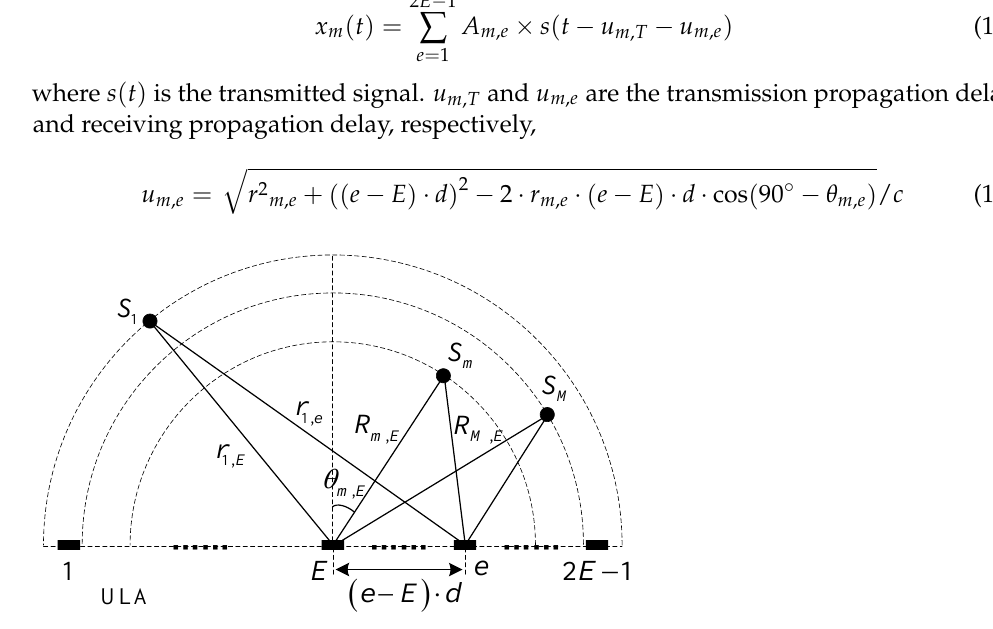
Figure 8. Sensor array and scattering point configuration. Figure 9 is the algorithm architecture of the echo signal fitting. The wideband LFM signal can be decomposed into multiple narrowband components via fast Fourier trans- form (FFT) [34]. For each narrowband component, the time delay processing can be con-